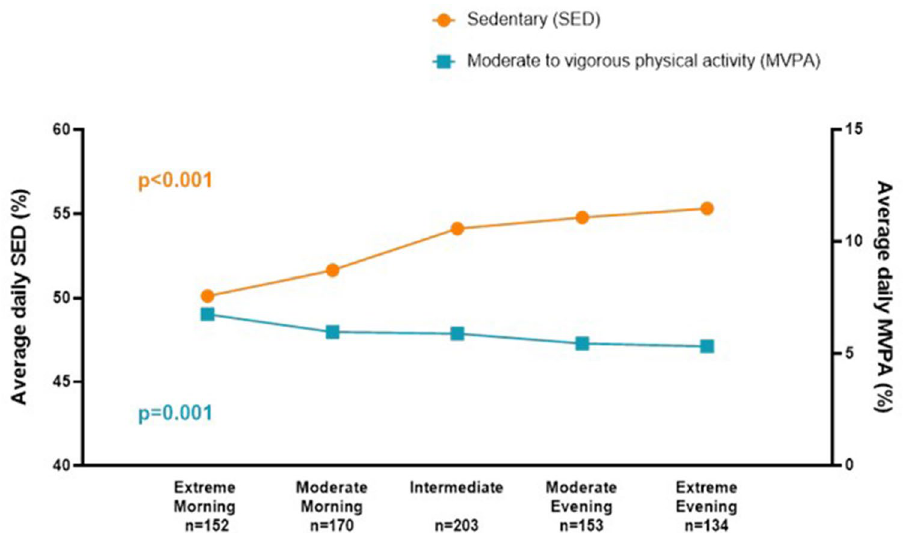
Figure 3. Physical activity pattern by chronotype. SED increases from extreme morning to extreme evening type (ANOVA, p < 0.001). MVPA decreases from extreme morning to extreme evening type (ANOVA, p =